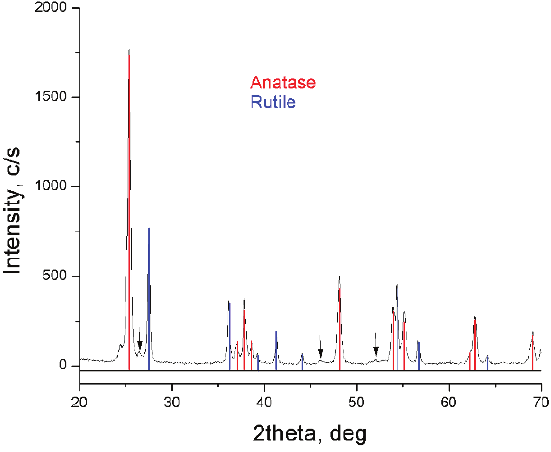
Figure 5. X-ray diffractograms of sol-gel synthesized TiO of an unidentified phase are shown with